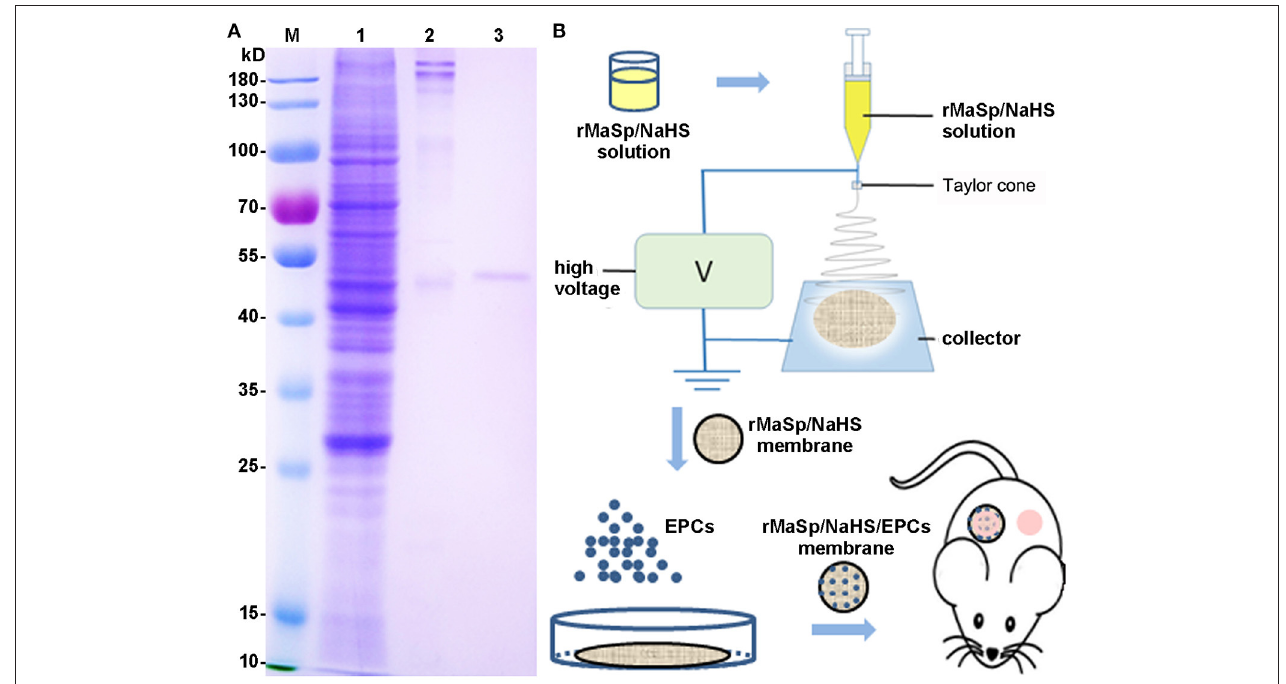
FIGURE 1 | Preparation of recombinant spider silk protein (rMaSp) and the schematic diagram of wound healing program. (A) Coomassie Brilliant Blue staining of rMaSp purification. Lanes of w1–3 are protein ladder, supernatant of lysate, precipitation of lysate, rMaSp, respectively. (B) The schematic diagram of wound healing program with rMaSp/sodium hydrogen sulfide (NaHS)/endothelial progenitor cell (EPC)